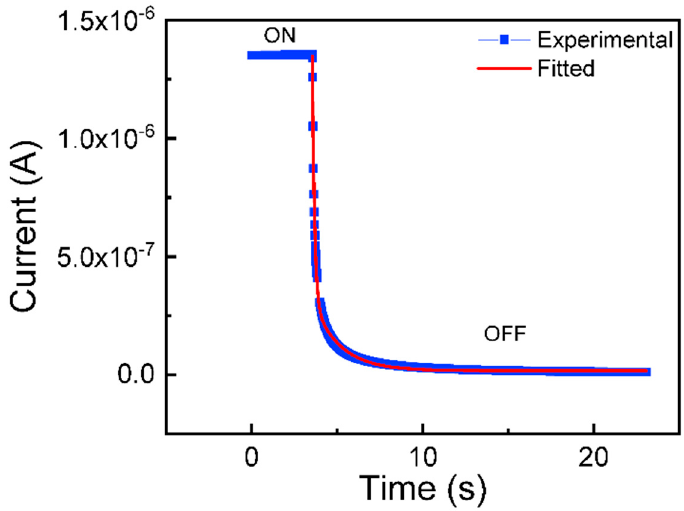
Figure 2. The decay of photocurrent as a function of time after turning off the illumination. The red curve indicates the fitting using biexponential equation.